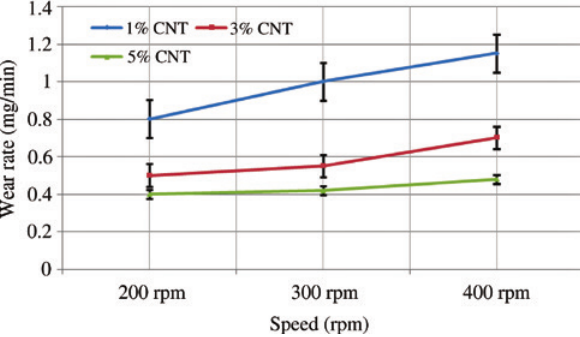
Figure 9: Difference in the rate of wear with respect to sliding speed for variation in % of CNT.